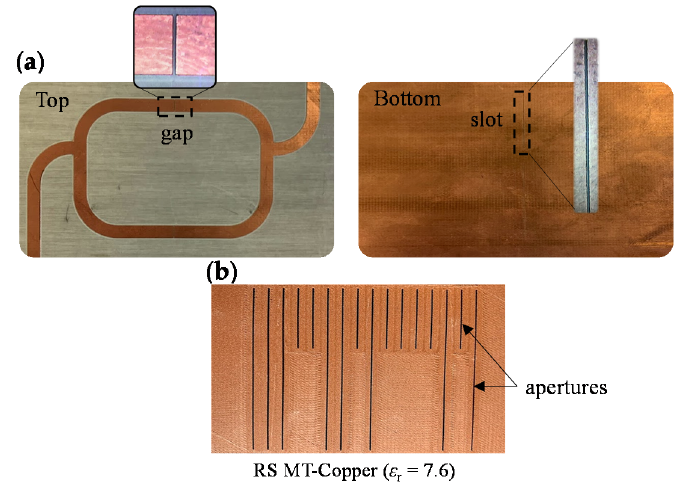
Figure 6. Photographs of the fabricated ( a ) sensitive part of the reader and ( b ) 3D-printed 16-bit encoder codified with a de Bruijn sequence.